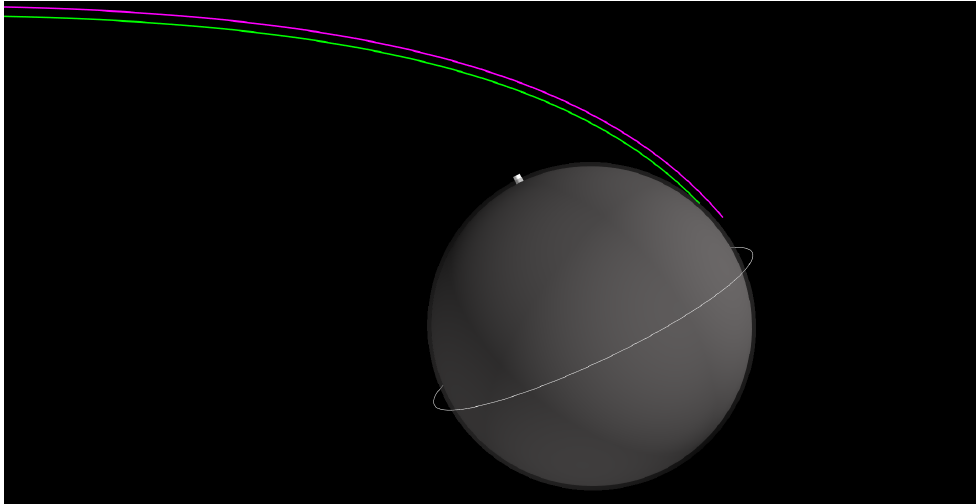
Figure 24. Hyperbolic approach trajectory of the Venus SmallSat (green) until entry interface and the approach trajectory of the host orbiter spacecraft (magenta) until periapsis.